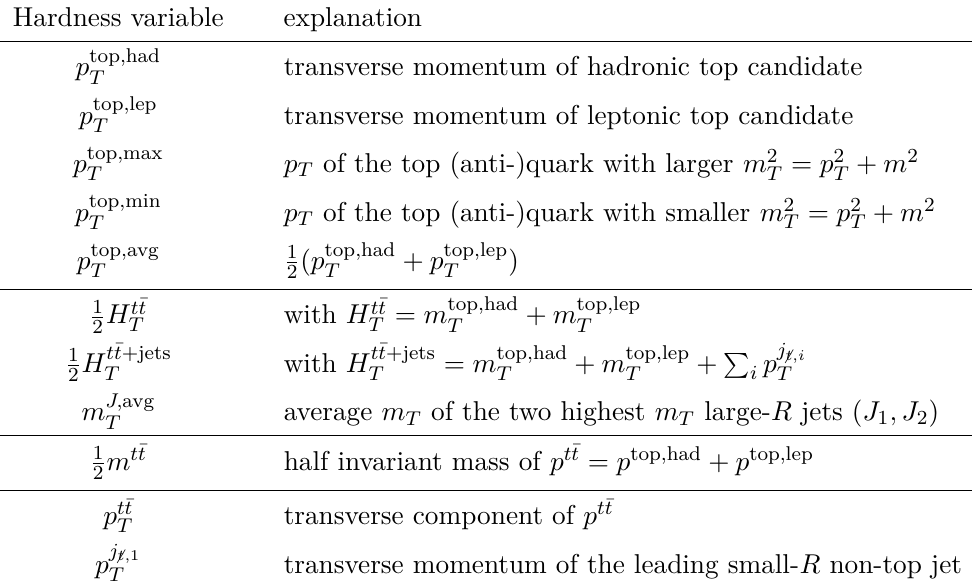
Table 1 . Variables that may be used to characterise a hard kinematic scale in events with a semi- leptonically decaying t ¯ t pair. All observables within a given group are identical to each other at leading order. The j jets correspond to R = 0 . 4 non-top jets, while the J 6 t,i large- R jets (whose clustering inputs include the top quarks). Further details about the jet finding are given in sections 3 and 4. The difference between m observables is largely p top,min T